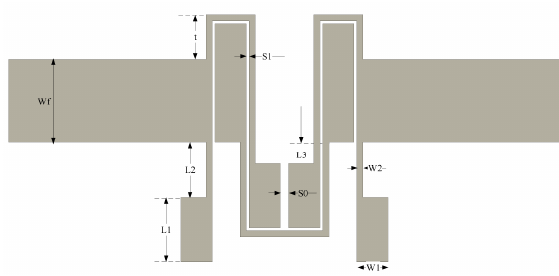
Figure 3. Layout of the band-pass filter.